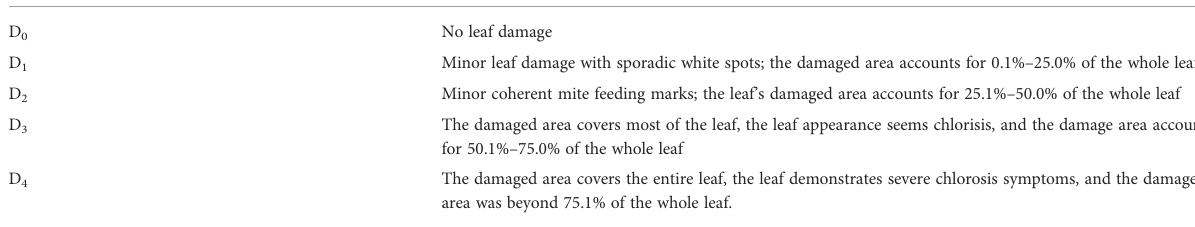
TABLE 1 Leaf damage scale classi fi cation and de fi nition. Leaf damage